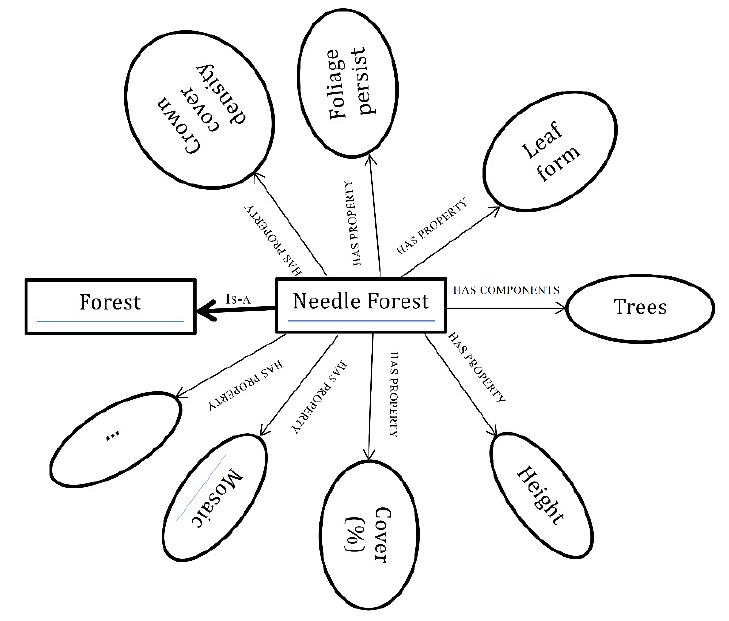
Figure 3. Coniferous forest in the local ontology of FROM-GLC-Seg.